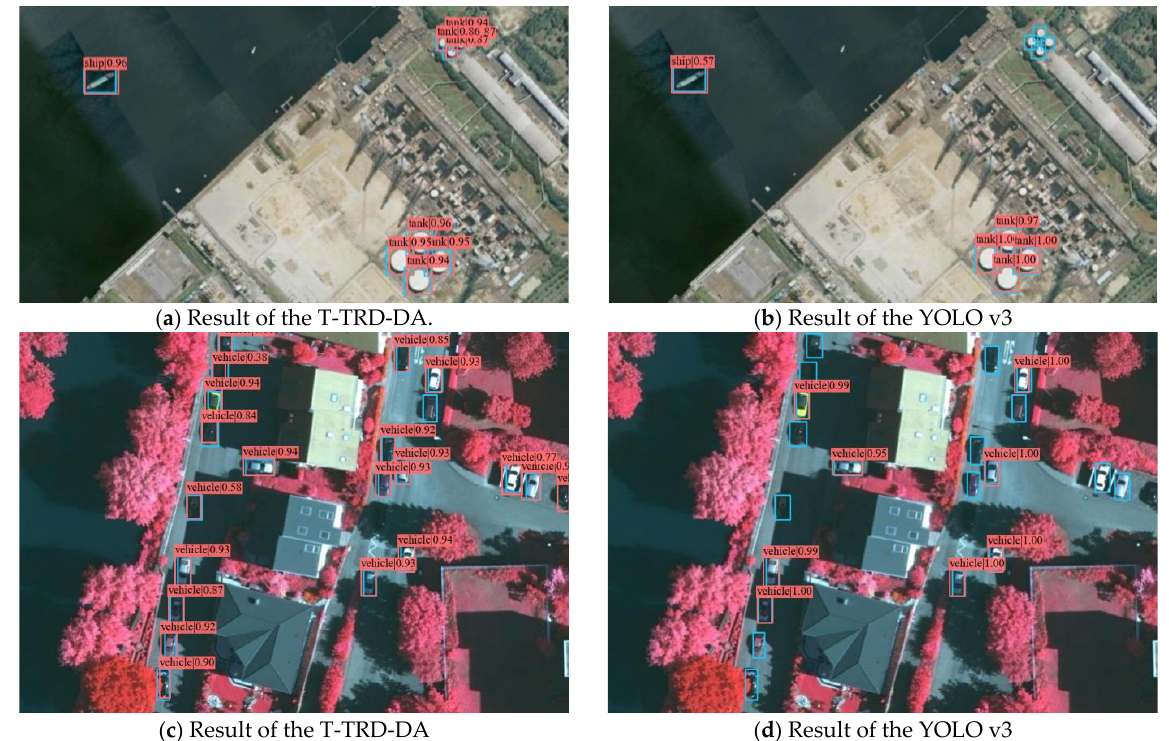
Figure 7. Comparison between T-TRD-DA (left) and YOLO v3 (right) on the NWPU VHR-10 data set.